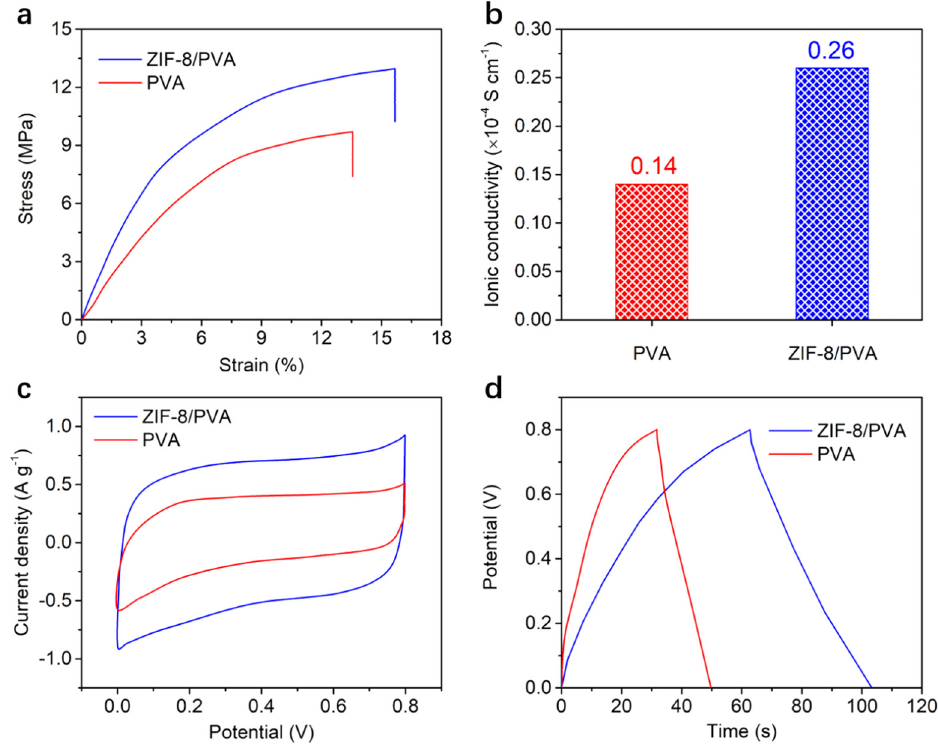
Figure 4: ( a ) Mechanical characterizations of pristine PVA and ZIF - 8 material - doped PVA membranes. ( b ) Comparison of ionic conductivity of the two membranes. ( c ) CV curves of the two membranes at scan rate of 5 mV s − 1 . ( d ) Charge – discharge curves of the two membranes at a current density of 0.5 A g − 1